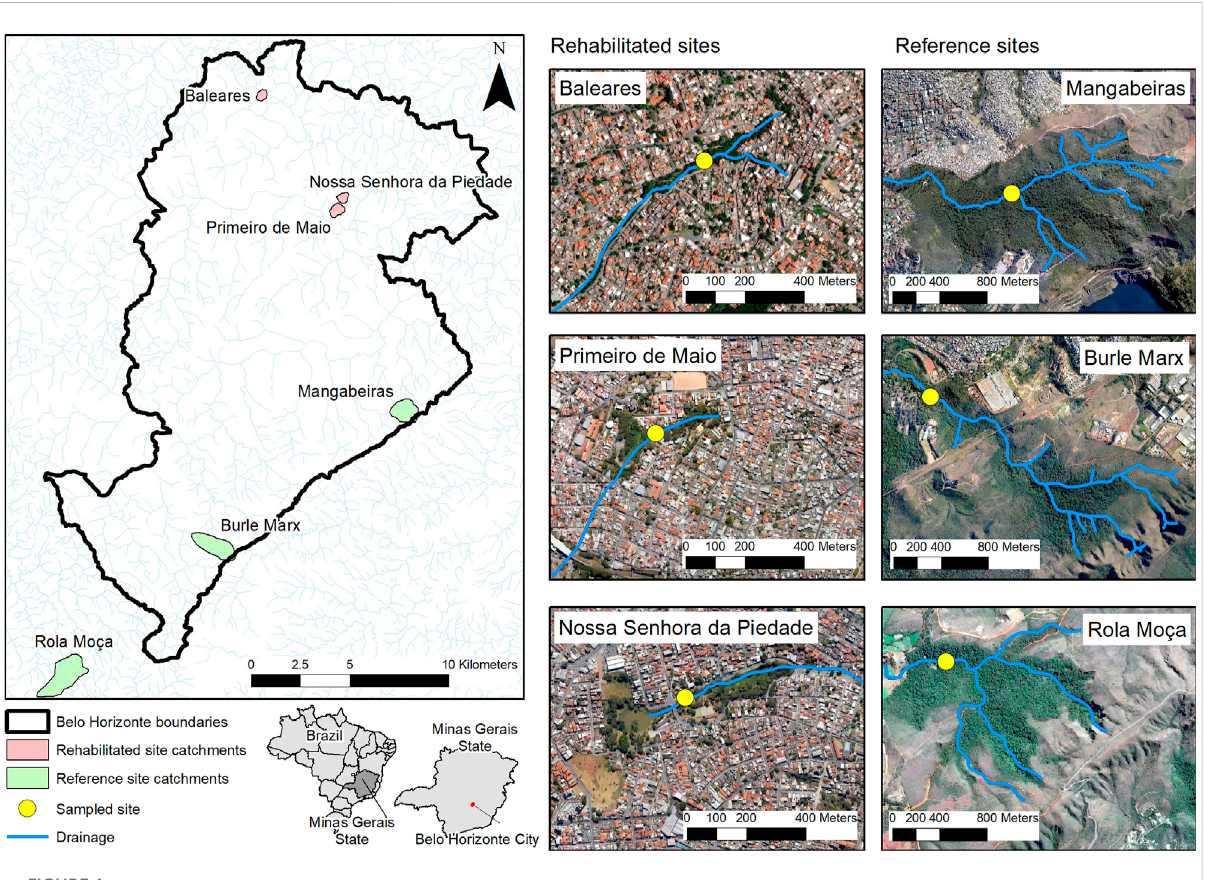
FIGURE 1 Map of study area, showing the test- and reference-stream